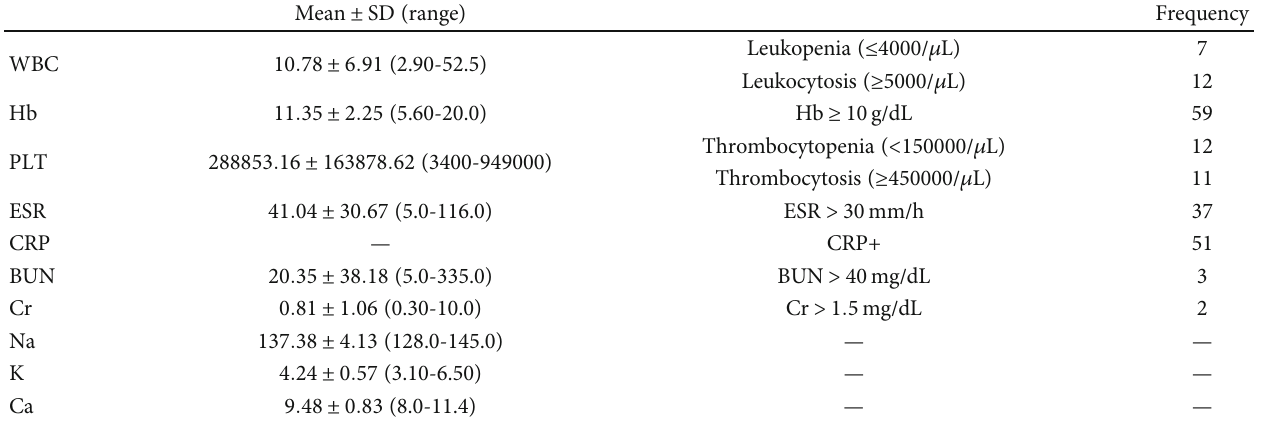
Table 3: The laboratory fi ndings of the patients with COVID-19 at admission time ( n = 100 ). Mean ± SD